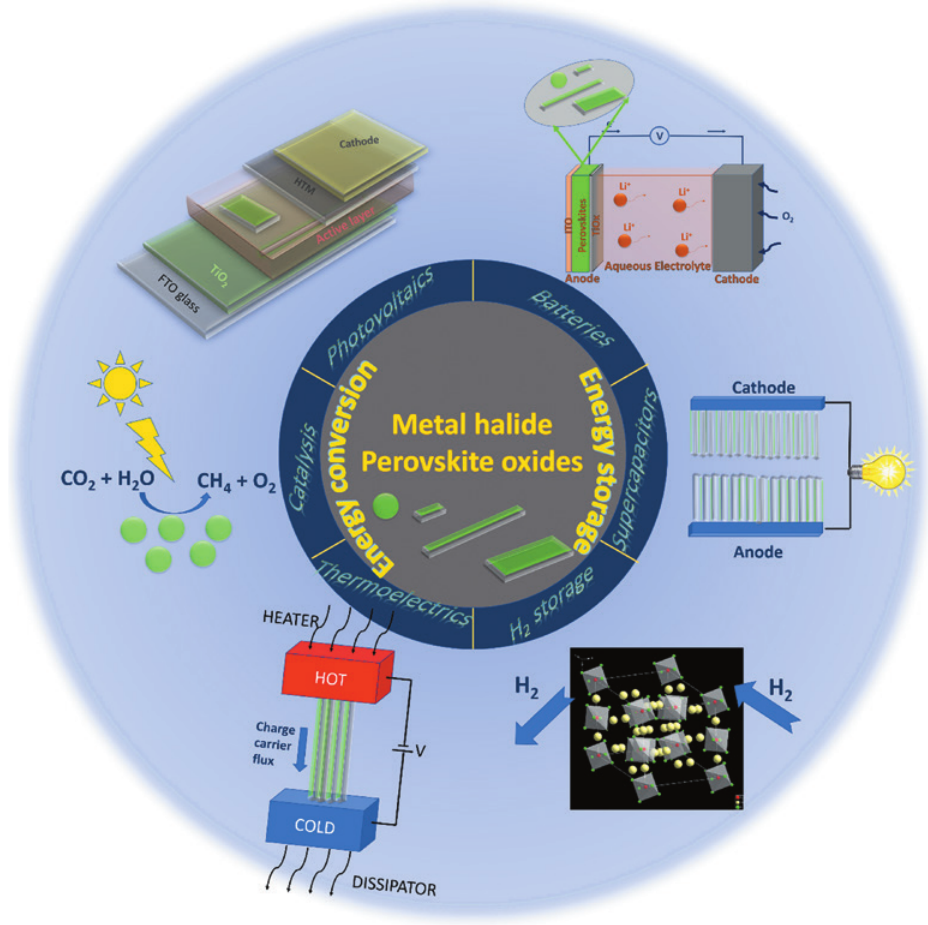
Figure 1: Applications of perovskite (metal halides and perovskite oxides) nanocrystals for energy conversion and